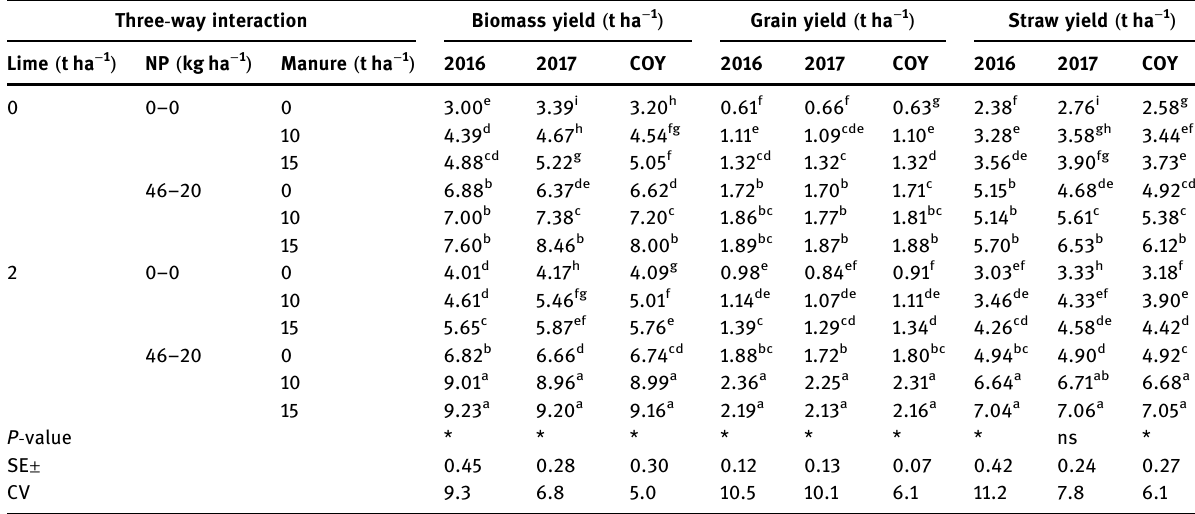
Table 5: Interaction e ff ects of lime, cattle manure, and NP fertilizers on grain, biomass, and straw yield of tef in 2016 and 2017 main cropping season in northwest Ethiopian